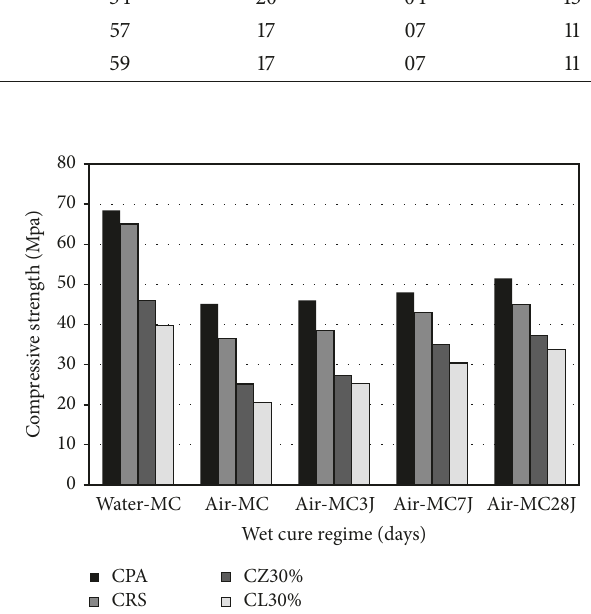
Figure 1: Effect of wet curing time on the mechanical